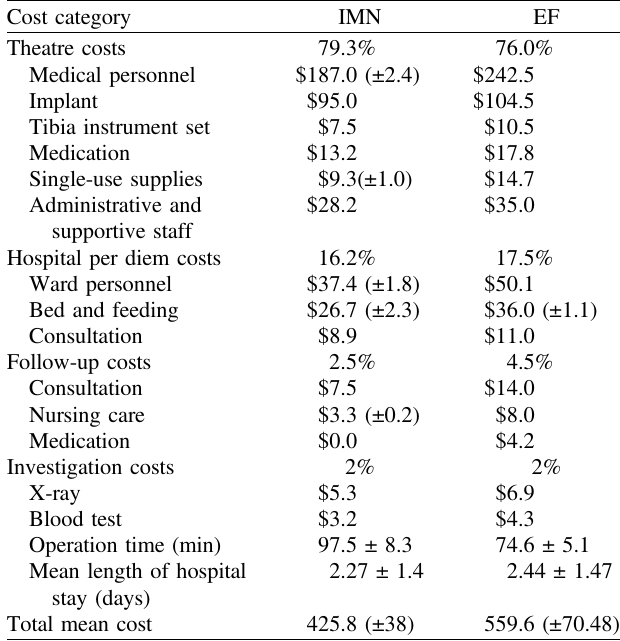
Table 2. Mean total (variable and fi xed) costs in the IMN and EF